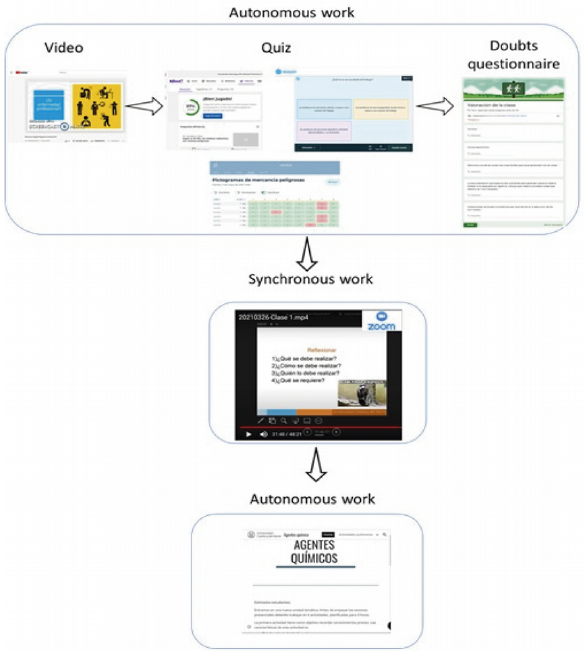
Figure 6. Example of activities and tools used in a learning sequence